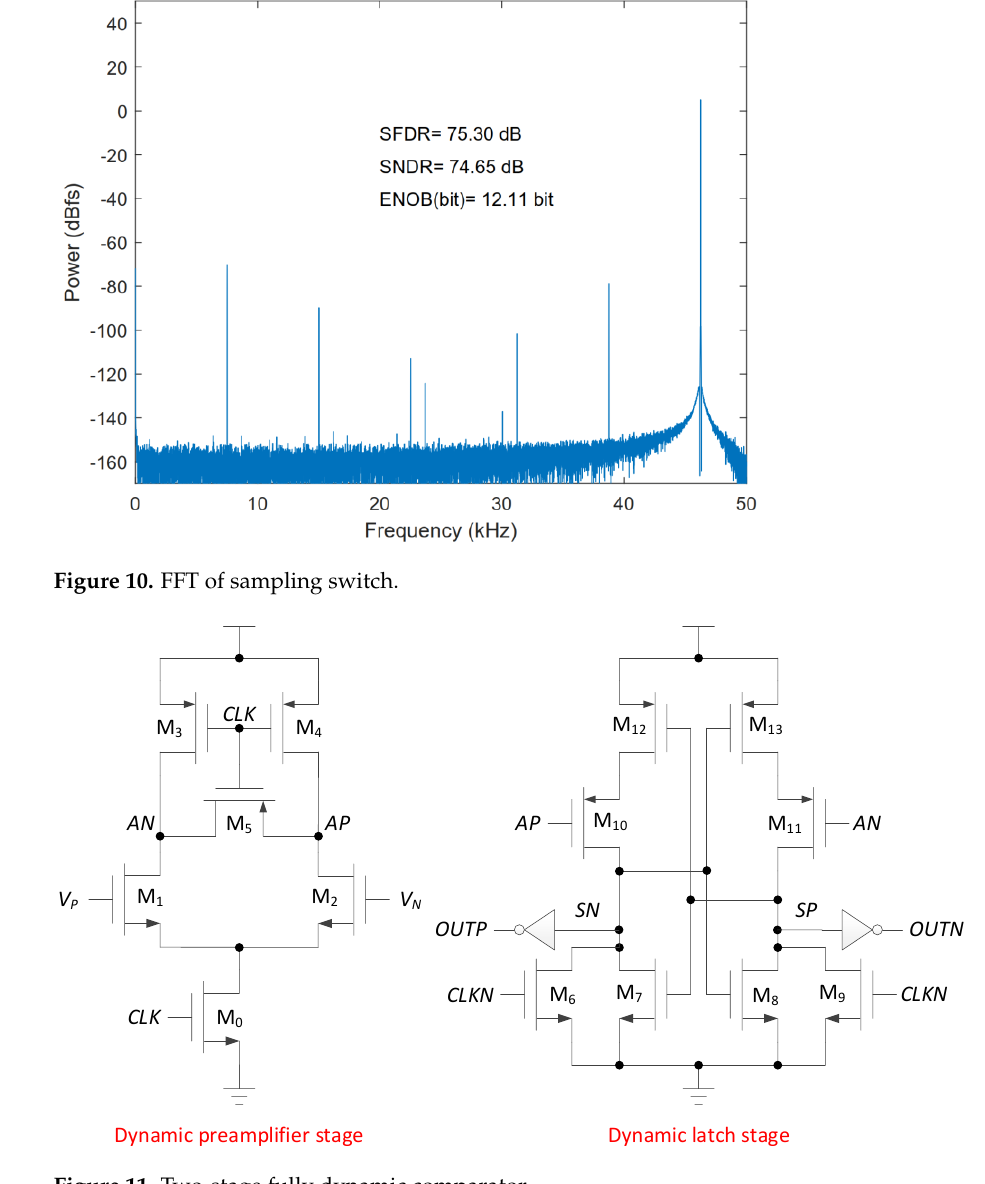
Figure 11. Two-stage fully dynamic comparator.